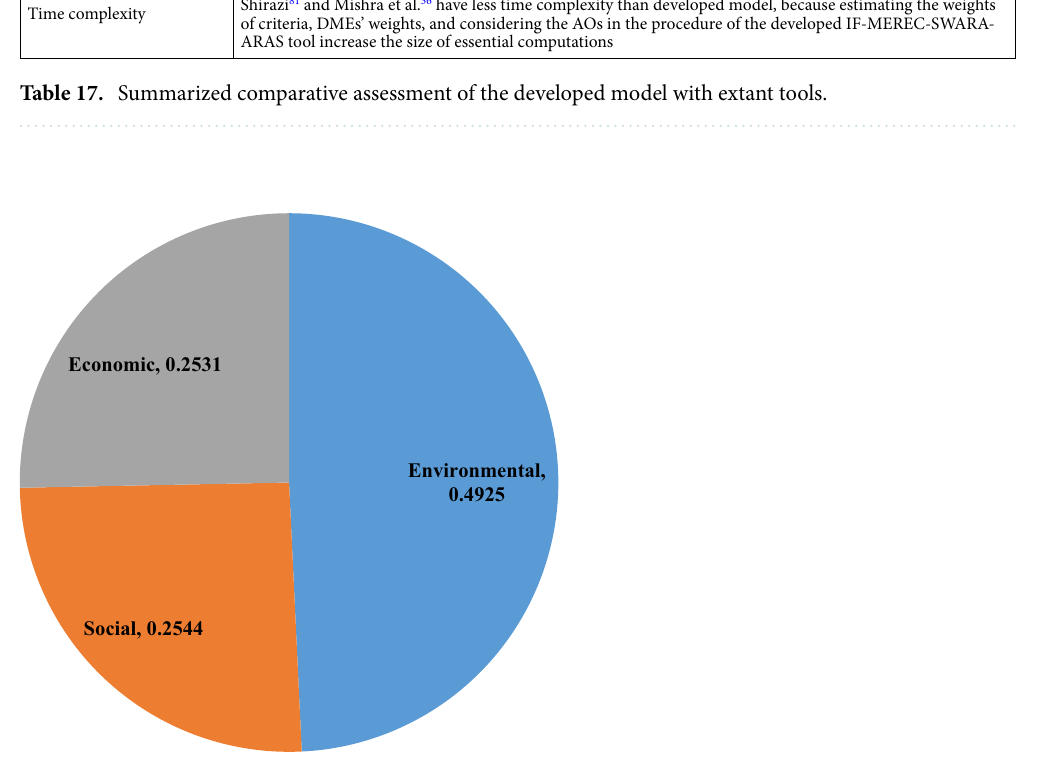
Figure 4. Relative weights of dimension of SDIs for SIBO